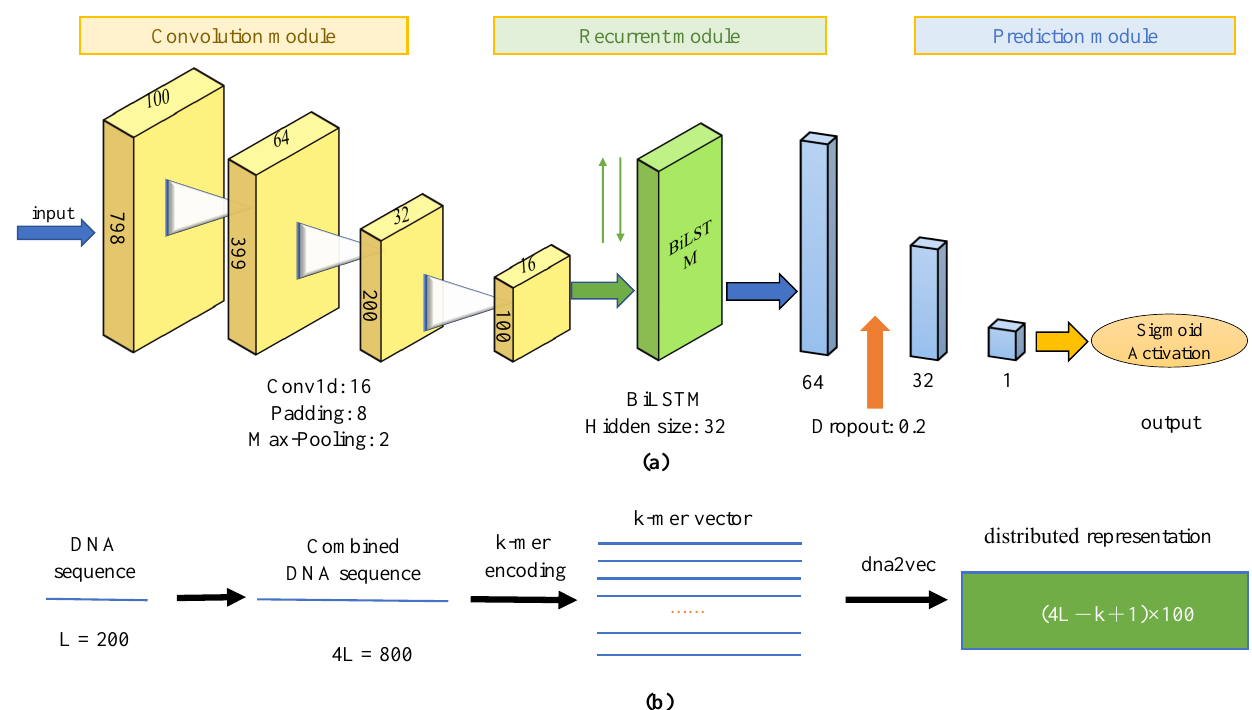
Figure 2. The illustrative diagram of our DeepD2V method for predicting protein–DNA binding. ( a ) The DeepD2V model includes three modules: convolution modules, recurrent module, and prediction module. Each convolutional module consists of four layers including convolution layer, rectified linear unit, batch normalization, and pooling; ( b ) DeepD2V takes as each input a DNA sequence of 200 bp, and generate three types of variant sequences concatenated to form a 800 bp sequence, followed by k -mers encoding and distributed representation by a dna2vec